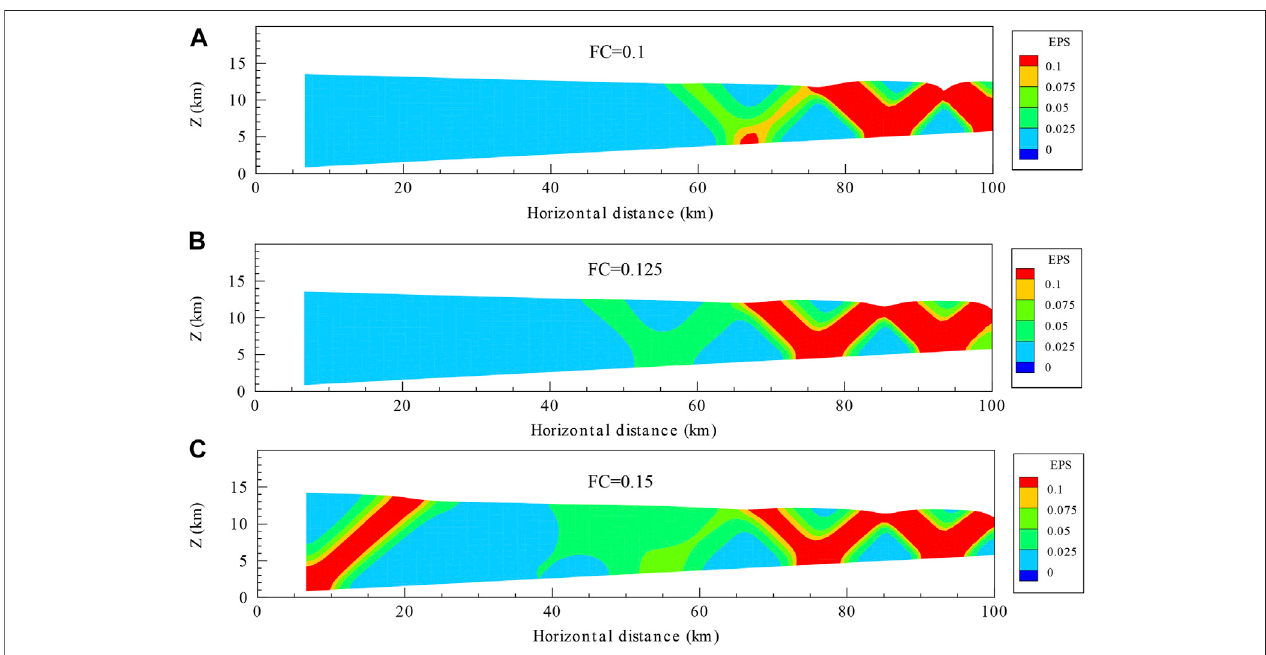
FIGURE11| FinalstateEPSformodelswithdifferentdecollementfrictionalcoef fi cients(FC).After6.6 kmofshorteningdisplacement,panels (A – C) showstatesof models 10, 11, and 12, which have frictional coef fi cients (FC) of (0.1, 0.125, 0.15), respectively. Plasticity concentration patterns are rather similar among them, and deformation starts in wedge ’ s thin region. When frictional coef fi cient is high, an extra zone of plasticity manifests in wedge ’ s thick region.